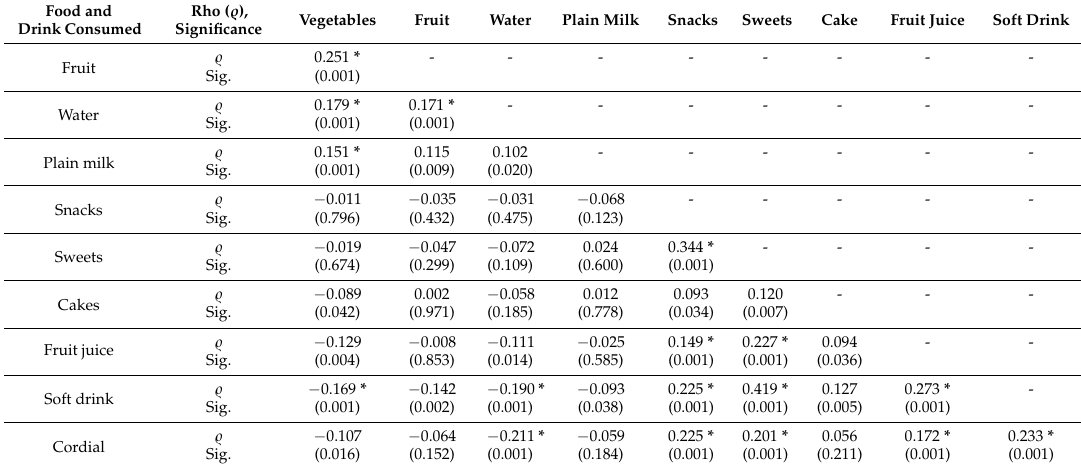
Table 2. Spearman’s rank correlation between food and drink servings.